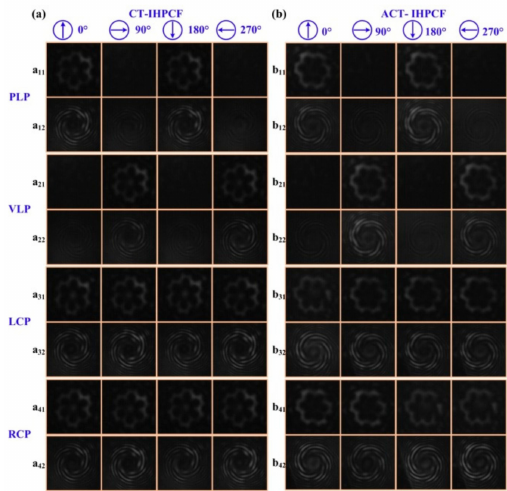
Figure 33. OAM ± 6 modes generated by the ( a ) CT- and ( b ) ACT-IHLPFG in the PCF at di ff erent polarization states of the input light